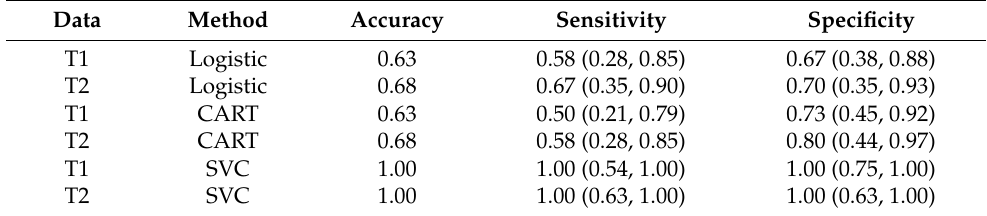
Table 7. Classification results for cardiac dysfunction in patients with myocardial